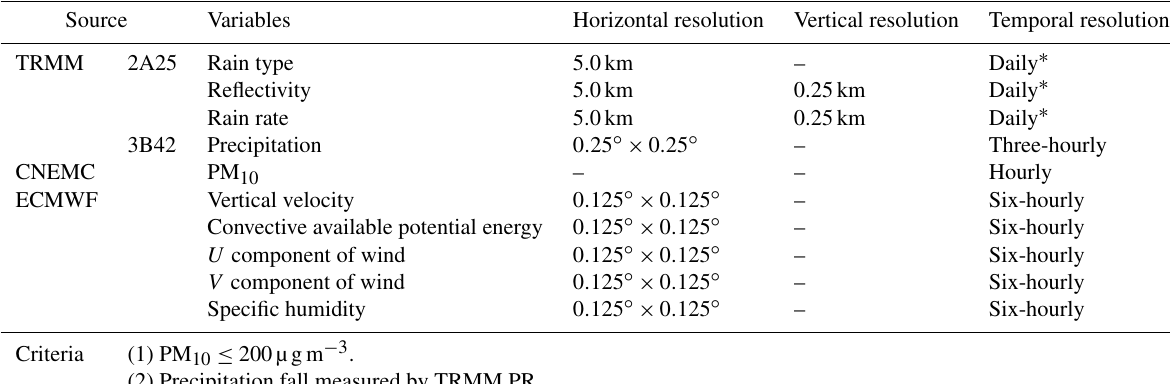
Table 1. Specifications from TRMM-PR-retrieved precipitation, China National Environmental Monitoring Center (CNEMC) in situ mea- sured PM 10 , and ECMWF reanalysis meteorological data used in this study for the period of 1 January 2007 to 31 December 2012. Criteria for selecting data for further comprehensive analysis are provided in the